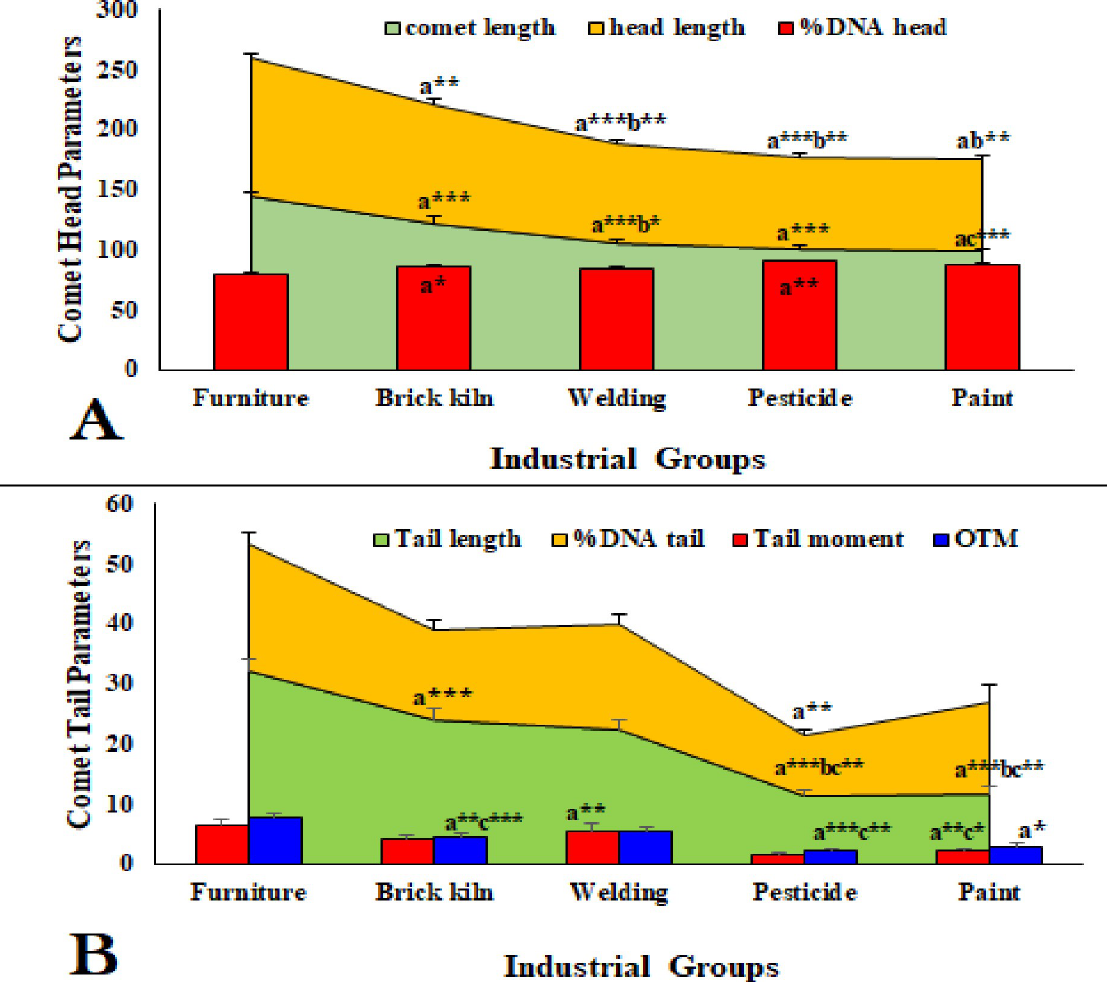
Fig 2. Different comet parameters associated with (A) comet head and (B) comet tail in lymphocytes of industrial workers. a = Furniture VS other industries, b = Brick kiln VS other industries, c = Welding VS other industries. � P < 0.05, �� P < 0.01, ��� P < 0.001.